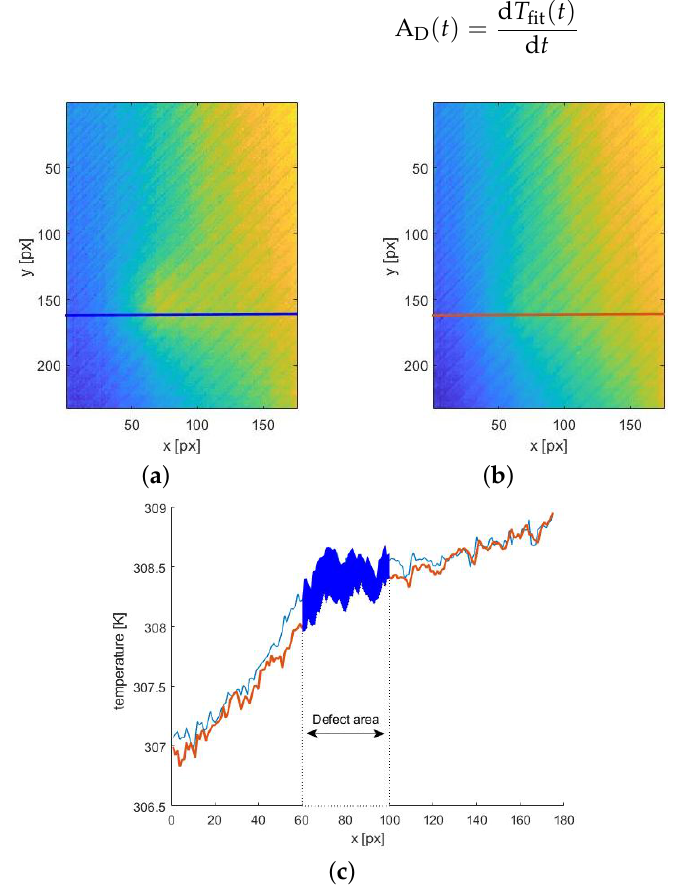
Figure 5. The results of the defect visibility enhancement procedure for the exemplary thermogram registered for defects having φ of 4 mm and D of 18 mm for t = 60 s: The original thermogram ( a ) and corresponding 2D distribution of the curve-fitting procedure ( b ); ( c ) presentation of the original and approximated 1D distribution along the lines depicted in ( a , b )—the coloured area marks the difference between the data in the defect zone. The dashed lines depicting the defect area correspond to the real localization of defects in the examined